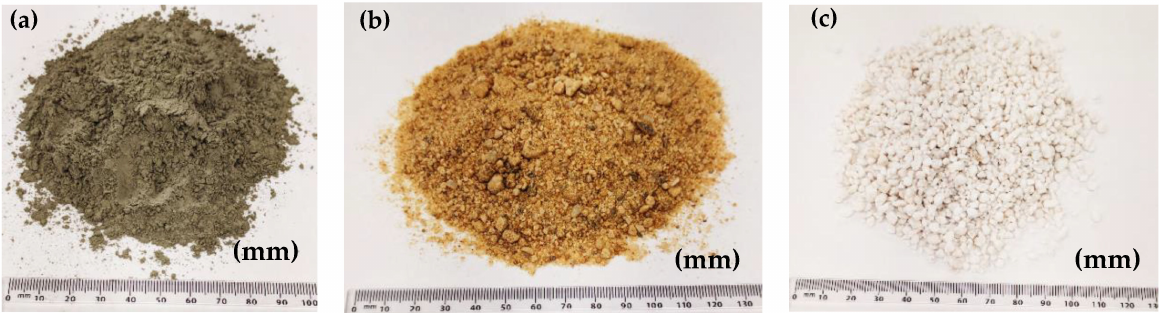
Figure 1. Materials: ( a ) cement; ( b ) sand; ( c ) expanded perlite.